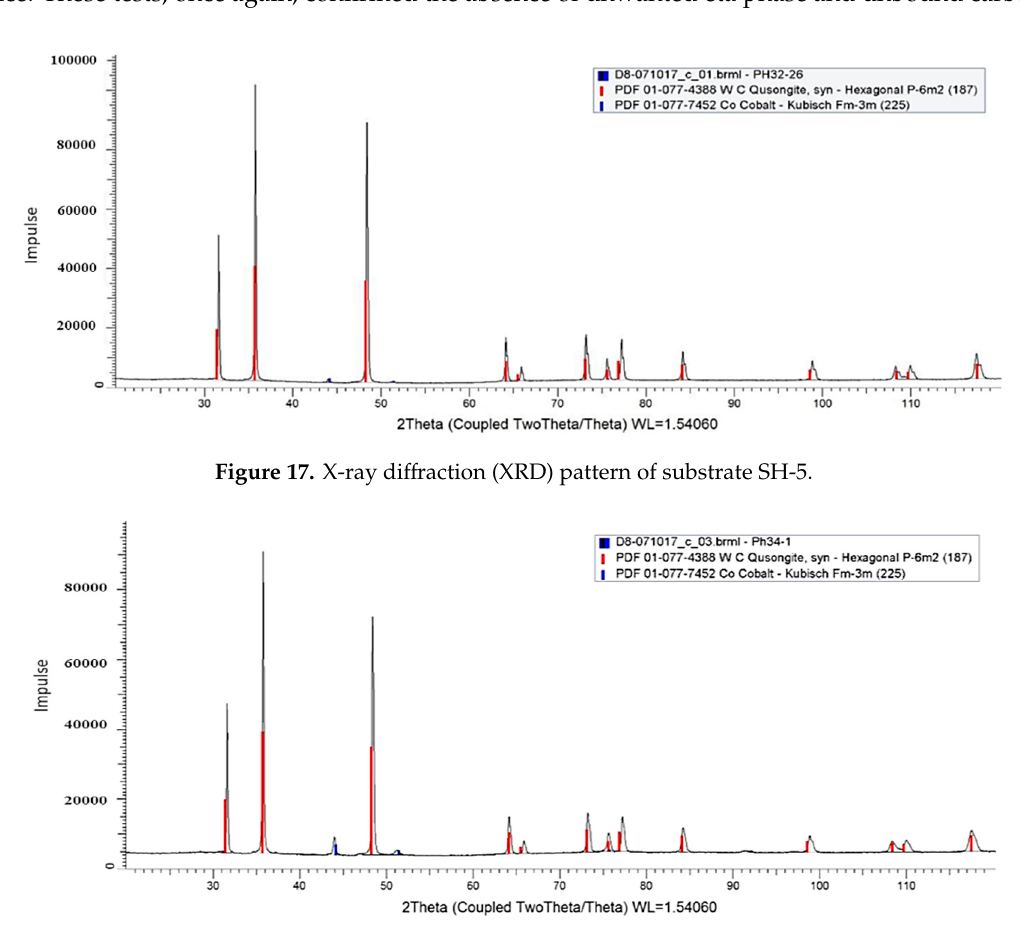
Figure 18. XRD pattern of substrate SH-15.